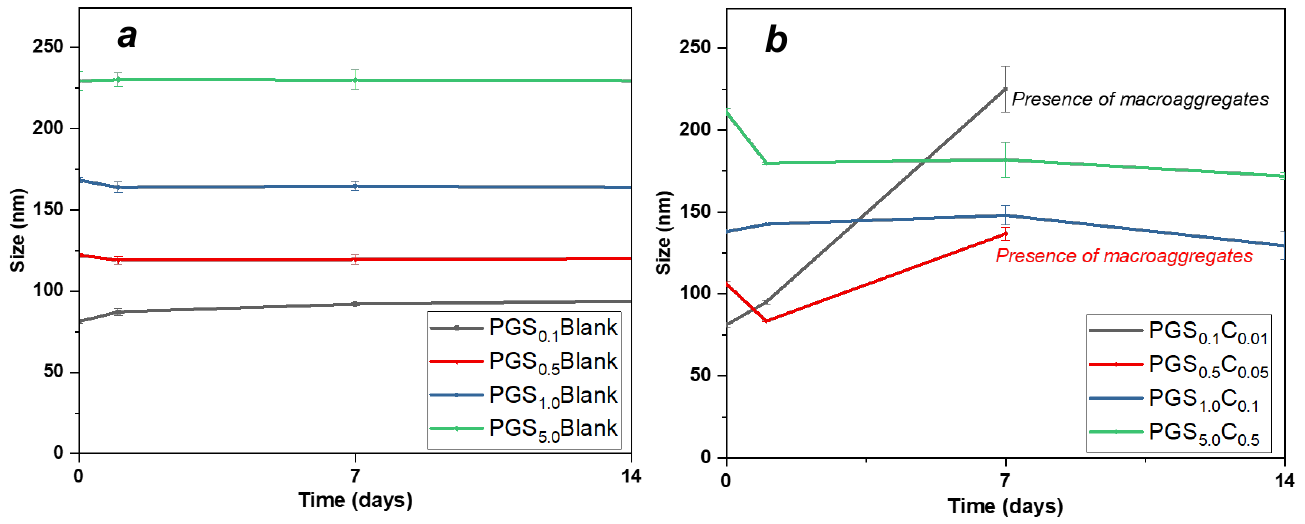
Figure 3. Hydrodynamic diameter of blank ( a ) and curcumin-loaded ( b ) PGS-NPs over time from sample preparation.